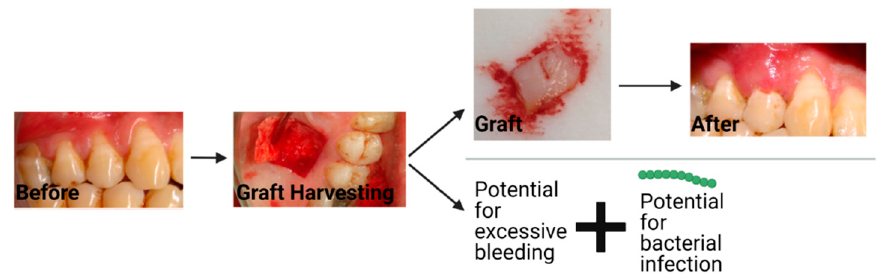
Figure 2. The workflow and potential complications that can occur with a connective tissue graft. The string of green dots represents bacteria. Created with BioRender.com with images from Dr. Michael Glogauer (University of Toronto) and images reproduced with permission under terms of the CC-BY license [31]. Copyright 2014, Sakshee Trivedi, Neeta Bhavsar, Kirti Dulani, and Rahul Trivedi published by the Journal of Clinical and Experimental Dentistry. Created with BioRender.com, accessed on 8 April 2022.